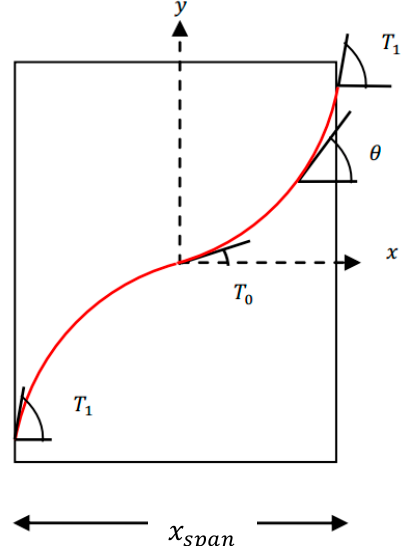
Figure 1. Reference curve with determining parameters. 𝜃 is the angle of the fibers in the transfer mode on the y axis, T 0 is the center angle of the reference curve, T 1 is the angle of the side edges, x is the coordinate of each point along the x axis, and x span is the range of x .